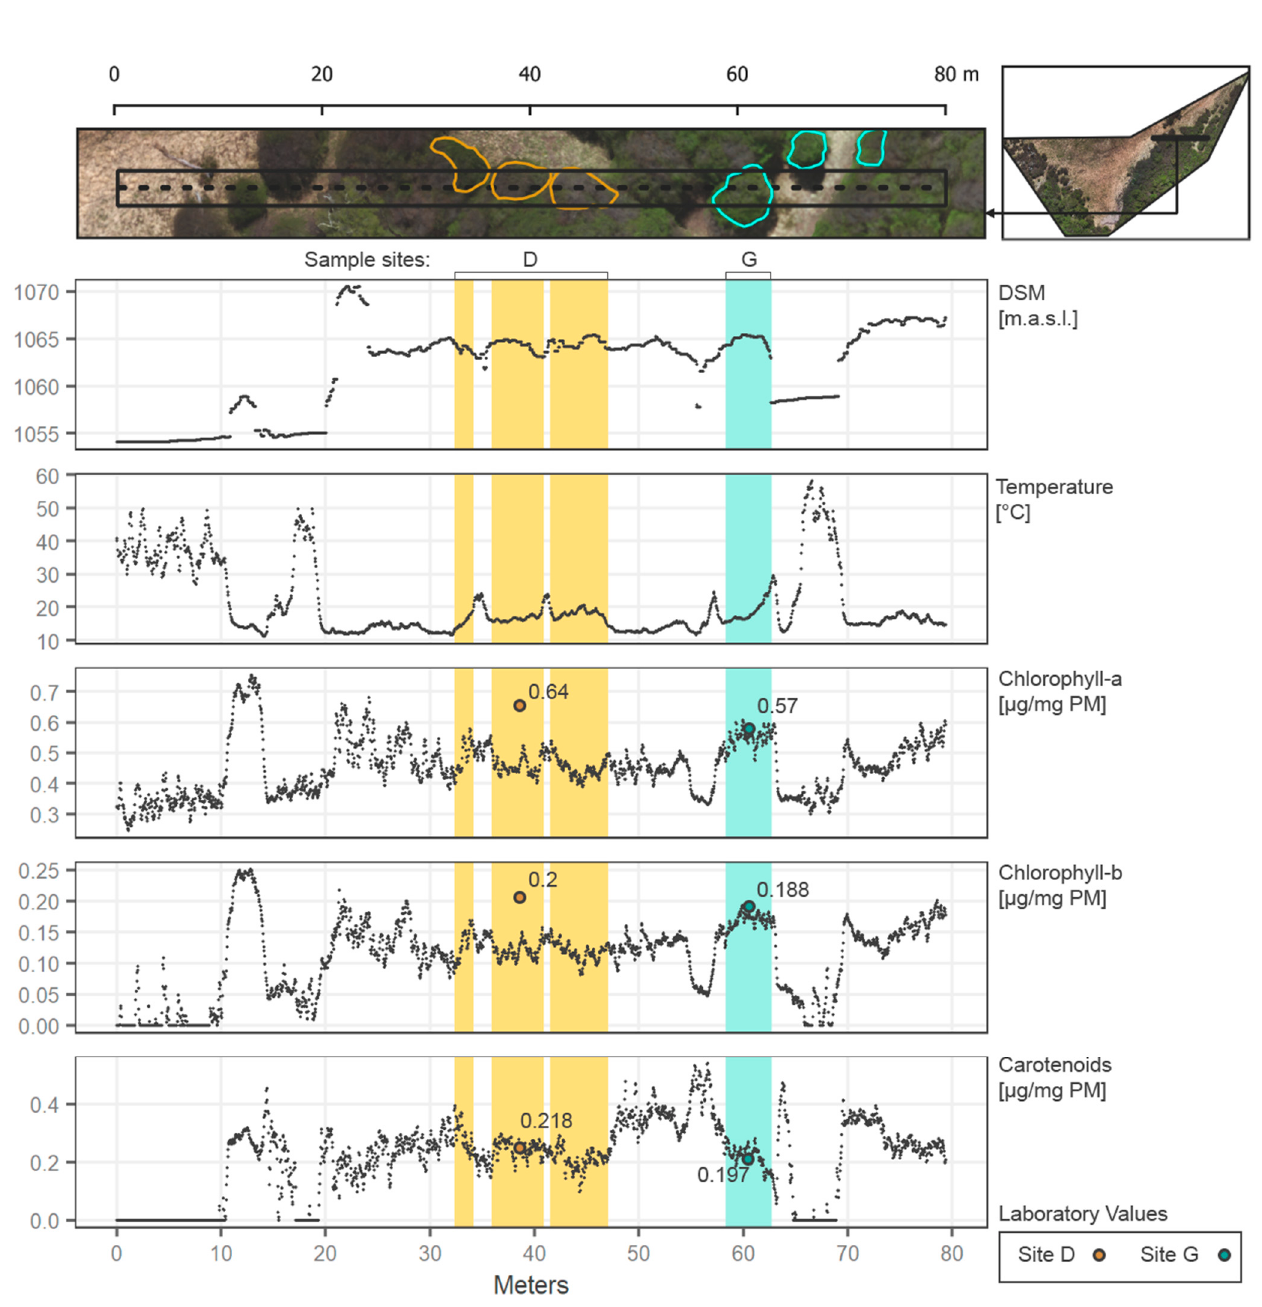
Figure 8. Transect (west to east) along the study area (80 m length) showing DSM, temperature, and pigments spatialized through the regressions from the vegetation indices. Points values are specified every 4 cm in the transect. Sampling sites D and G are included in the transect and specified.